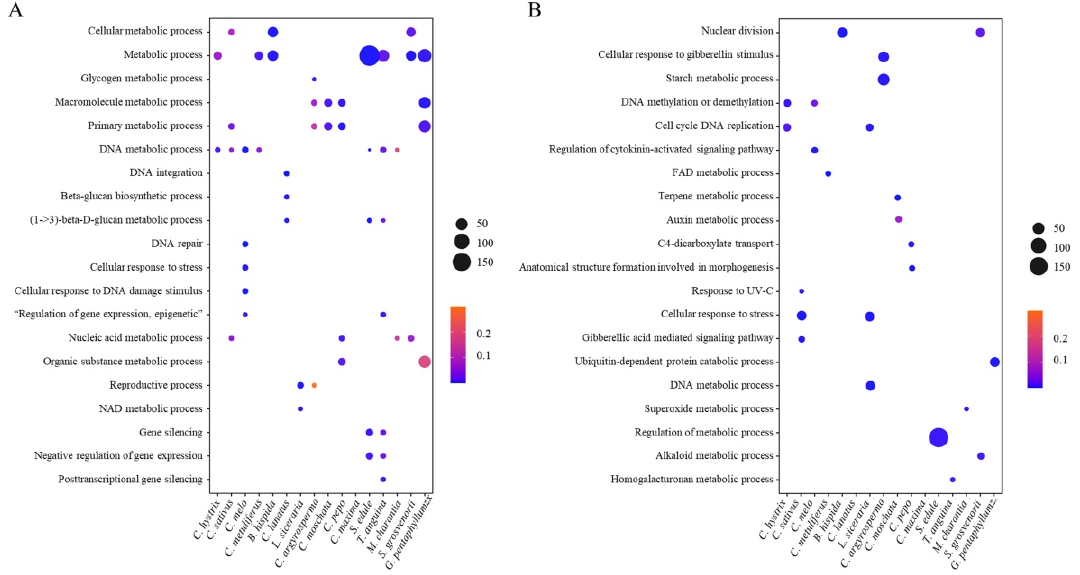
Figure 8. GO enrichment of genes associated with LTR-RT insertion. ( A ) Function enrichment of genes with TE insertion in introns. ( B ) Function enrichment of genes with TE insertions in promot ‐ ers.